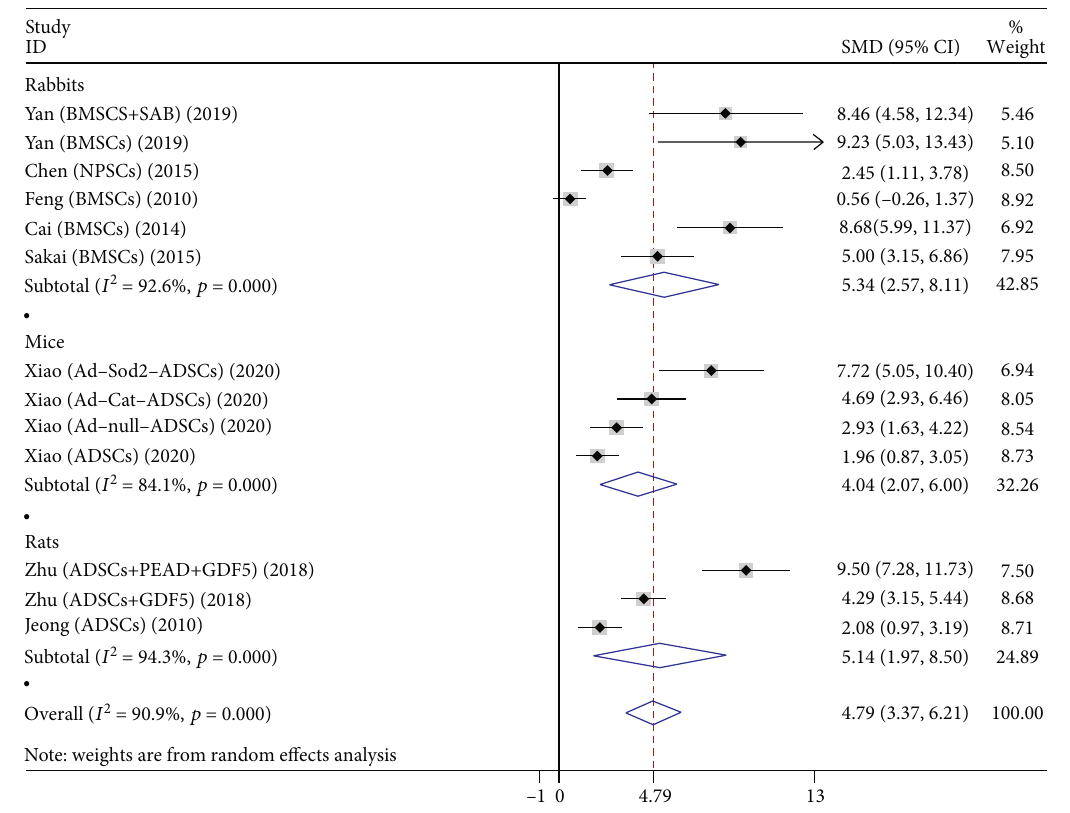
Figure 7: Forest plot showing the e ff ect of stem cell group and control group on T2 signal intensity in animal